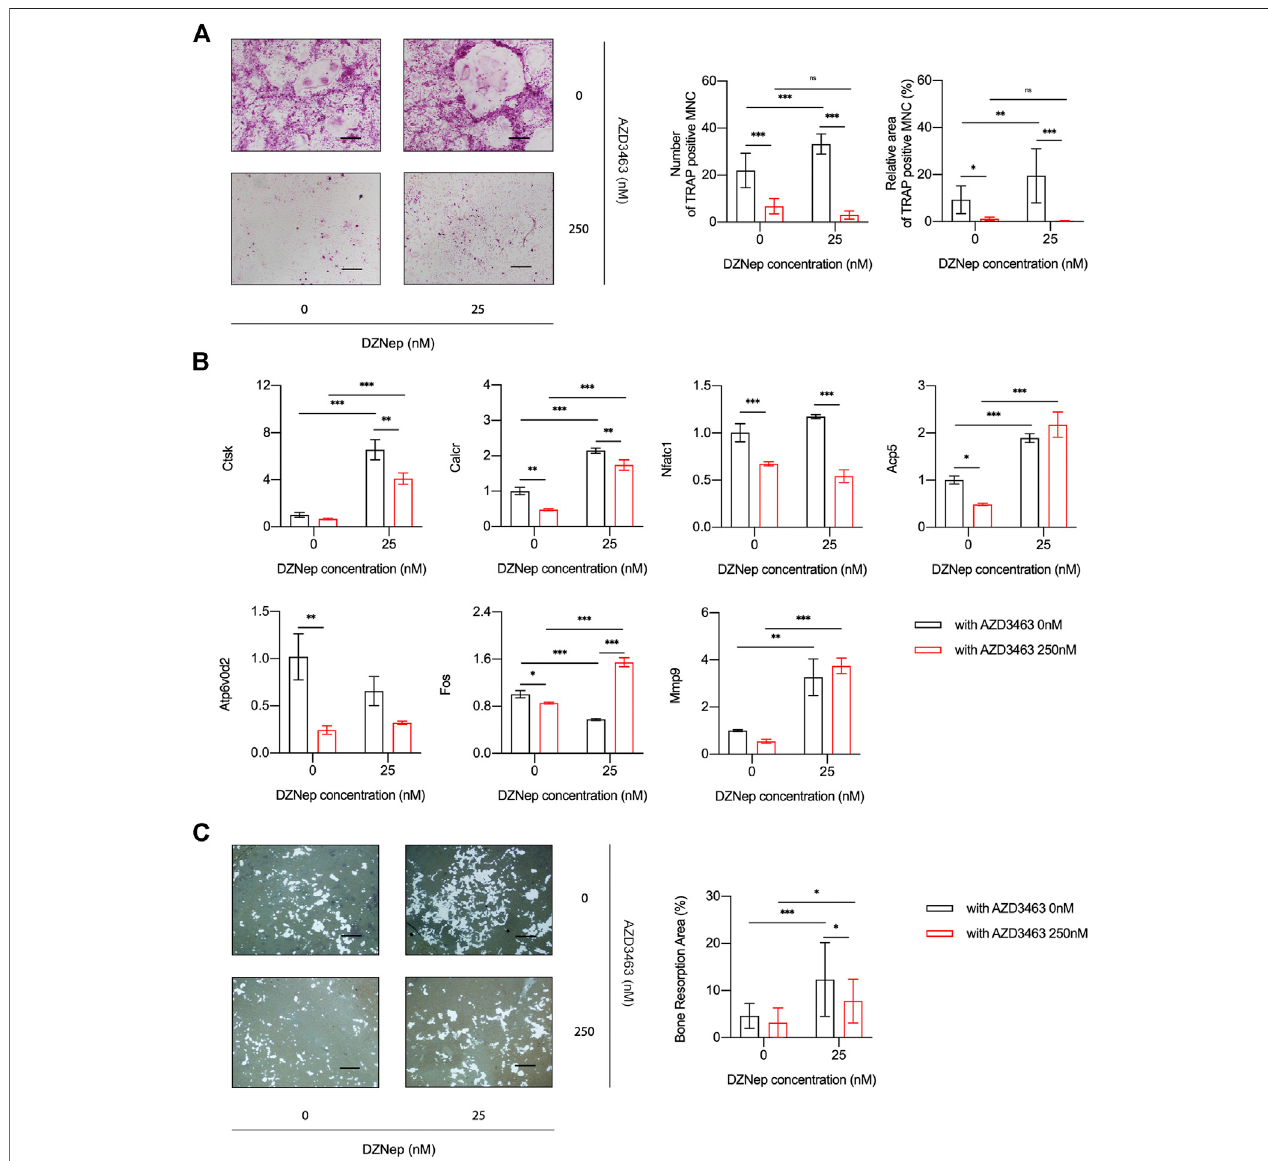
FIGURE 2 | DZNep and AZD3463 in fl uenced osteoclastogenesis in vitro . (A) TRAP staining indicated increased osteoclast differentiation after treatment with DZNep (25 nM), which was prevented by AZD3463 (250 nM). Scale bar (cid:2) 10 μ m. (B) Osteoclast differentiation-related mRNA expression increased in the DZNep (25 nM) group and decreased in the AZD3463 (250 nM) group. (C) Bone resorption assay using hydroxyapatite-coated microplates showed a larger area of resorption pits after treatment with DZNep (25 nM), which was alleviated by AZD3463 (250 nM). Scale bar (cid:2) 10 μ m. MNC: multinucleated